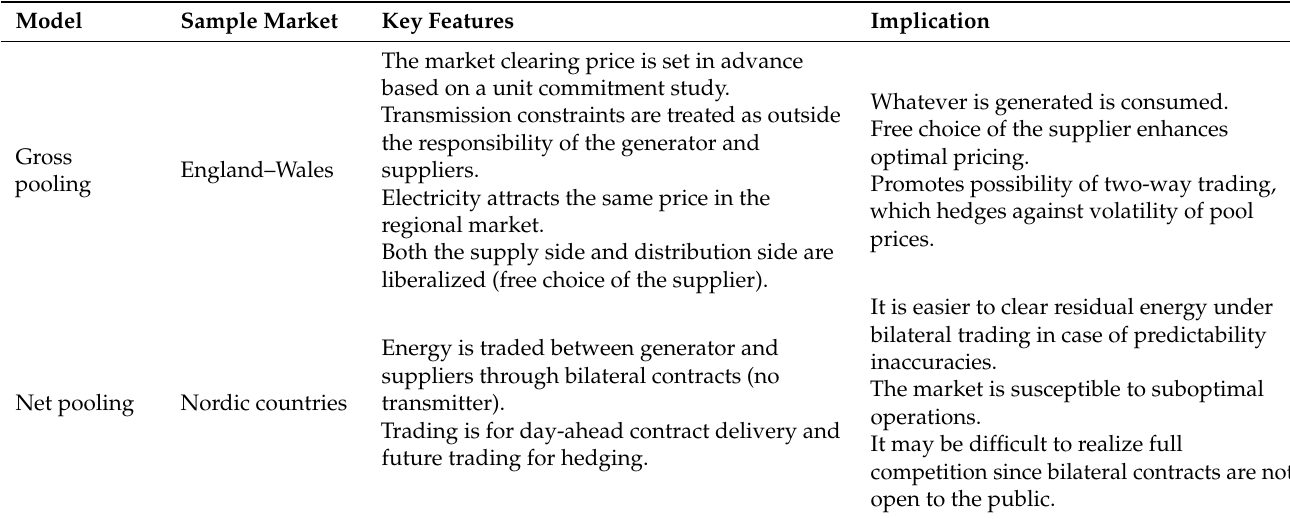
Table 10. Some applied electricity pooling models